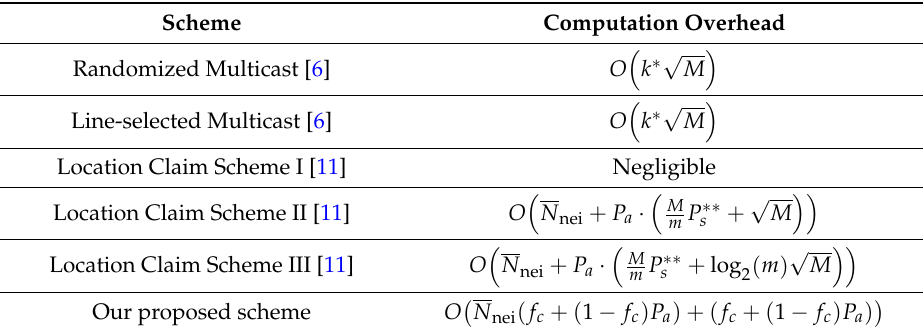
Table 3. Computation overhead comparison.